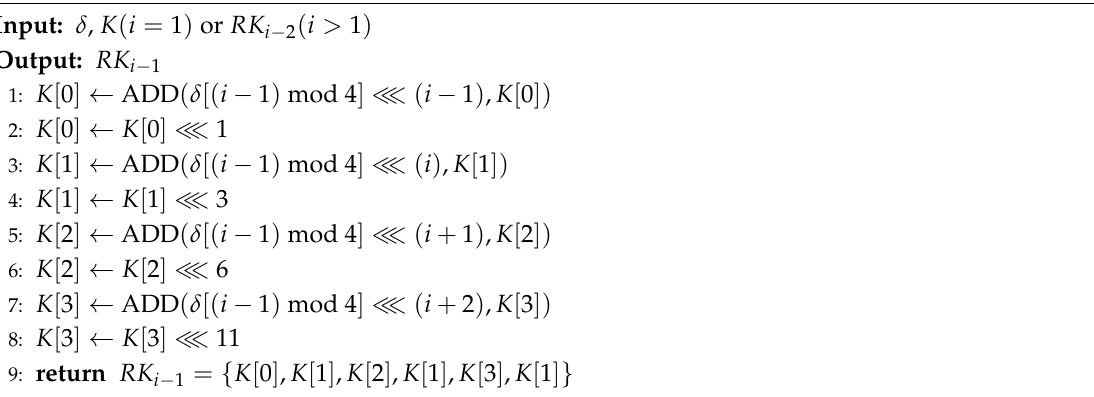
Algorithm 10 i -th key schedule of LEA-128.